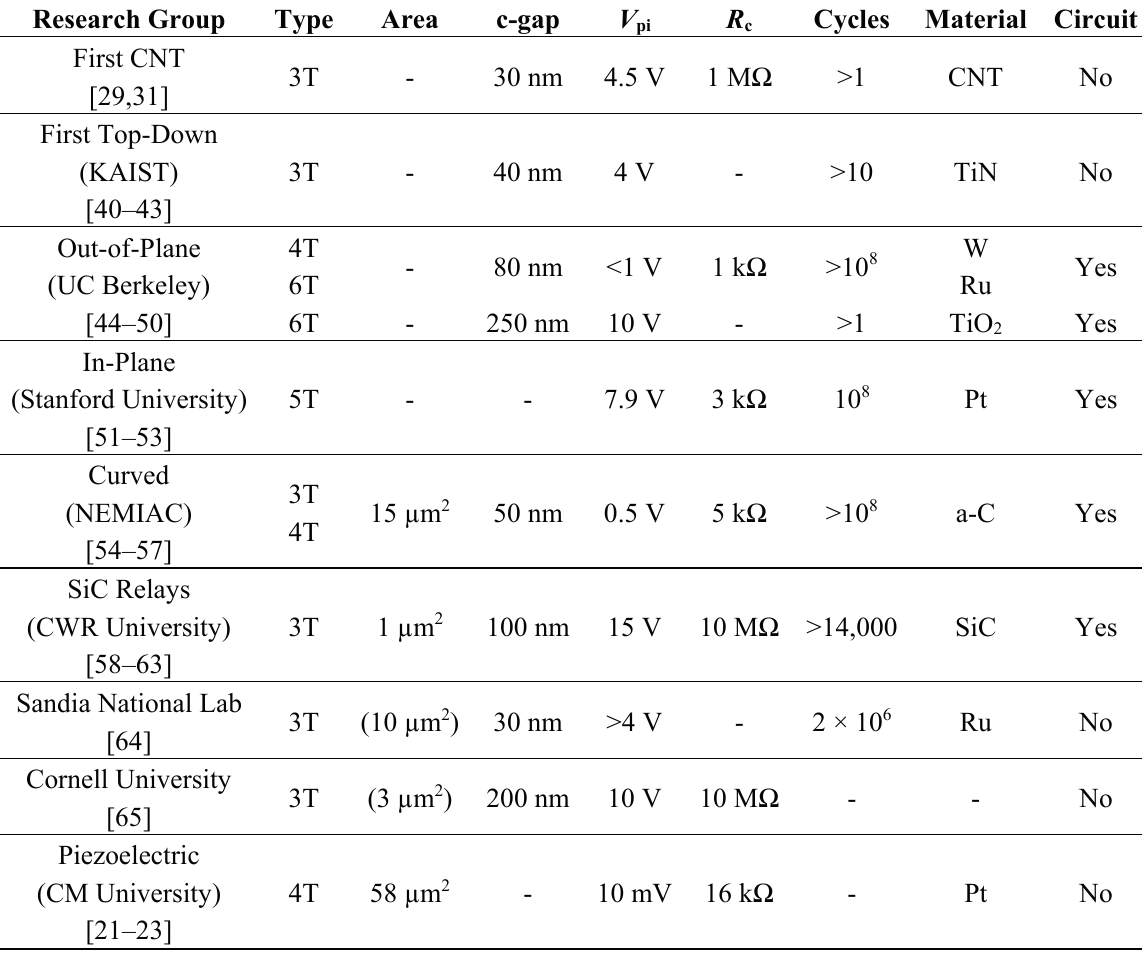
Table 1. Summary of reported nano-electro-mechanical (NEM) relays for logic applications (Areas in parentheses are